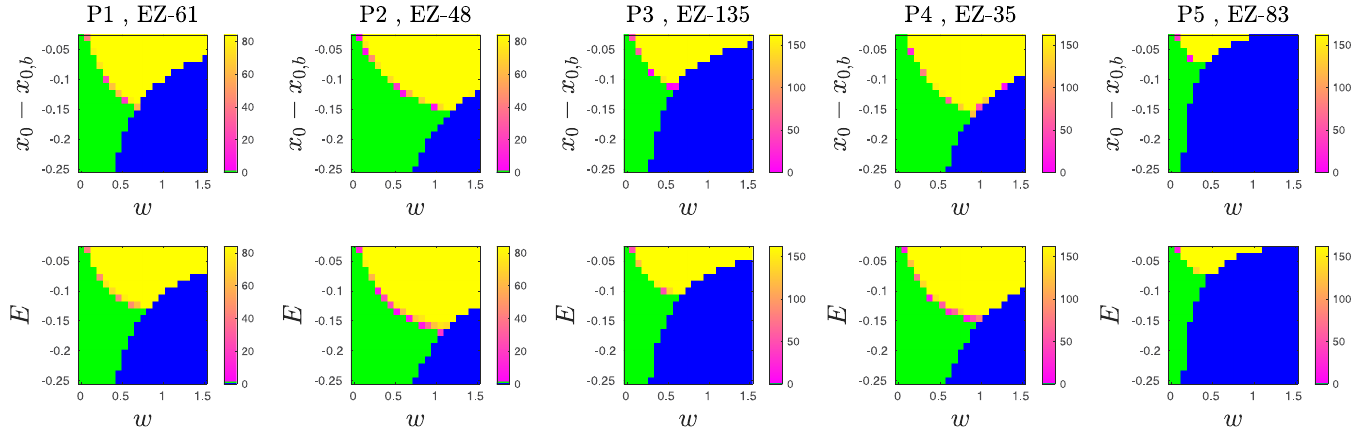
Fig 2. A comparison of the seizure-spread phase diagrams from patient-specific Epileptor networks and proposed probabilistic model. Each panel shows a phase diagram in the space of excitability and global interaction weight. Phase diagrams of the Epileptor network models are shown on the top row for 5 different patient- specific networks. The corresponding diagrams for the probabilistic model are shown on the bottom row. The regions colored as green, yellow, and blue correspond to the phases no-spread (i.e. the seizure remains localized to the epileptogenic zone), spread, and no-seizure (i.e. even the epileptogenic zone does not go into seizure, indicating a strong restrain effect of the surrounding nodes). The colorbar indicates the average spread size across stochastic realizations. The yellow region consists mostly of full spread cases, as illustrated in in Fig 1A and 1B by the time series from both the Epileptor network and probabilistic model network models. Cases of partial small spread are observed closer to the phase boundaries. Note that, while the horizontal axes of top and bottom panels are the same, we set the vertical axes of top panels to be centered at x 0, for the phase diagrams of Epileptor model in the top row to be comparable with those of the proposed probabilistic model in the bottom b